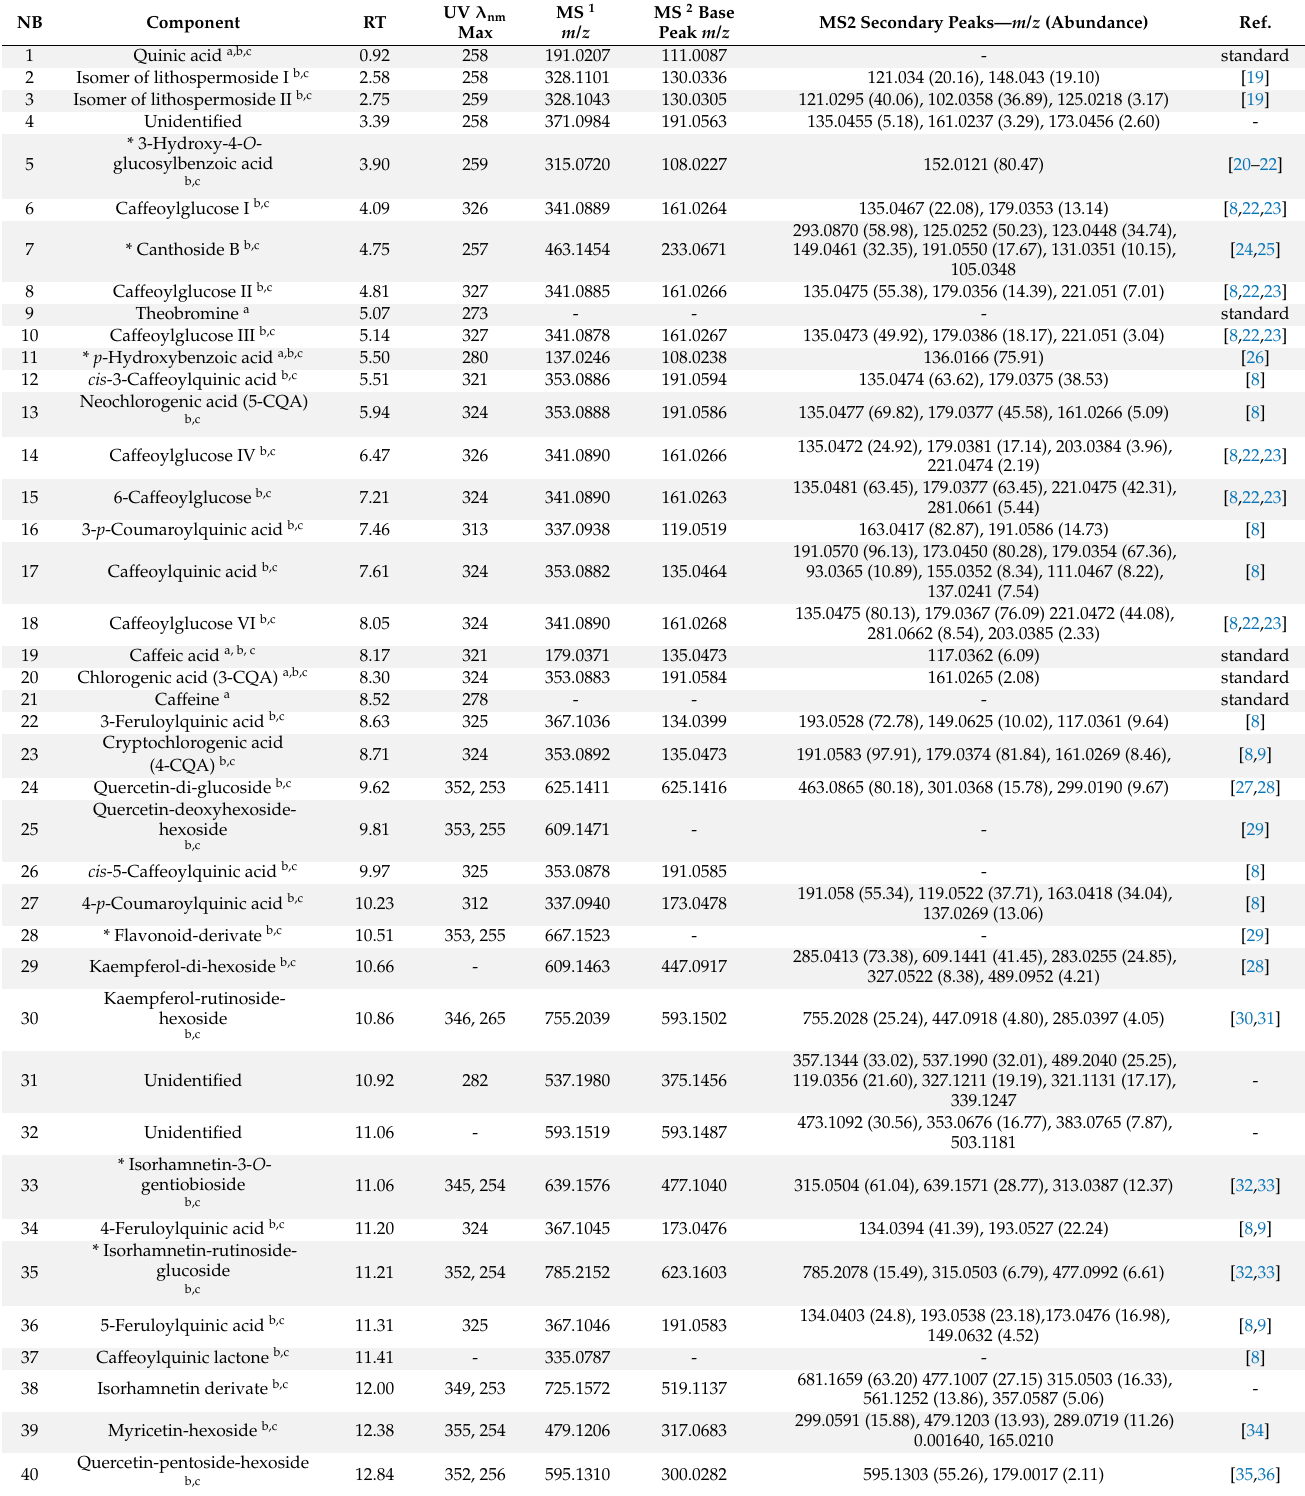
Table 1. UHPLC-DAD-MS/MS identification of components in Ilex leaves water